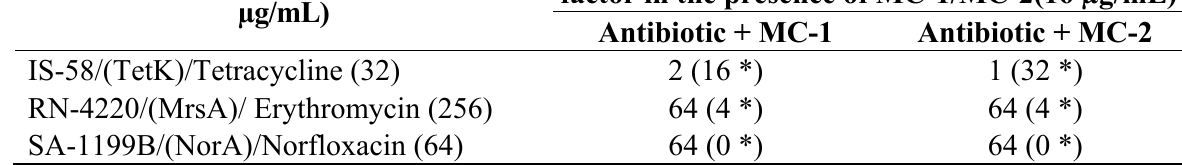
Table 2. MIC values (µg/mL) of test strains for antibiotics in the absence and presence of MC-1 and MC-2 (16